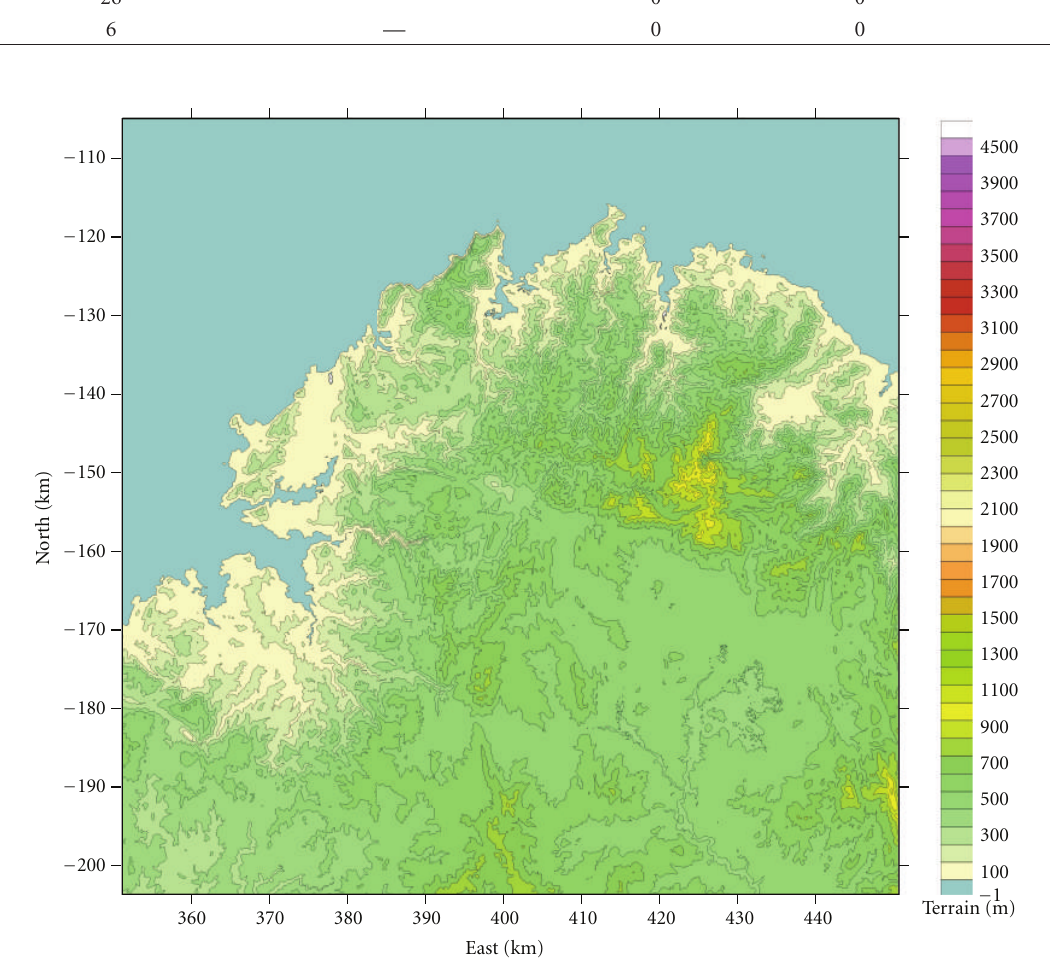
Figure 1: Topography of the area under